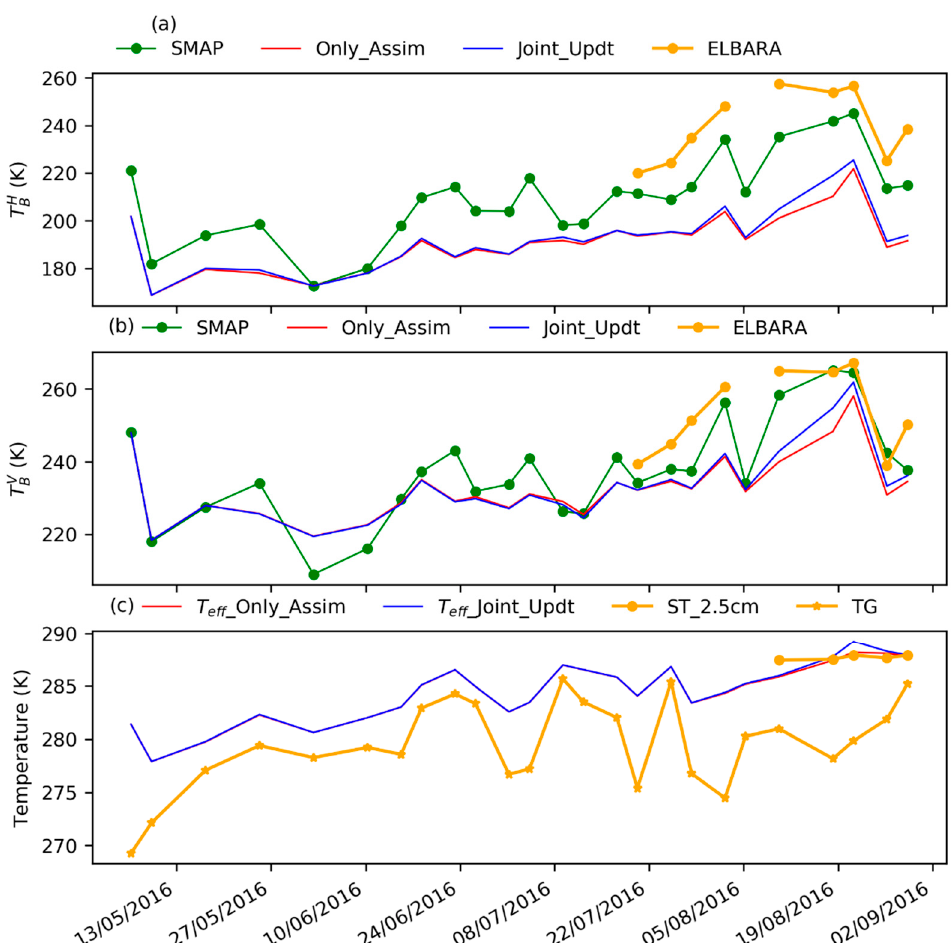
Figure 11. Comparisons of the SMAP T p , T p estimated by the two DA experiments and the ELBARA-III observed T p during the assimilation period (from 1 May 2016 to 31 August 2016), as well as comparisons of T ef f . ( a ) is for T H comparison, ( b ) is for T V comparison, and ( c ) is for T ef f comparison. The in situ soil temperature at 2.5 cm (ST_2.5cm) is available from 7 August 2016 onwards. TG denotes the ground surface temperature, which is derived based on the in situ measured downward and upward longwave radiations and the Stefan–Boltzmann equation.